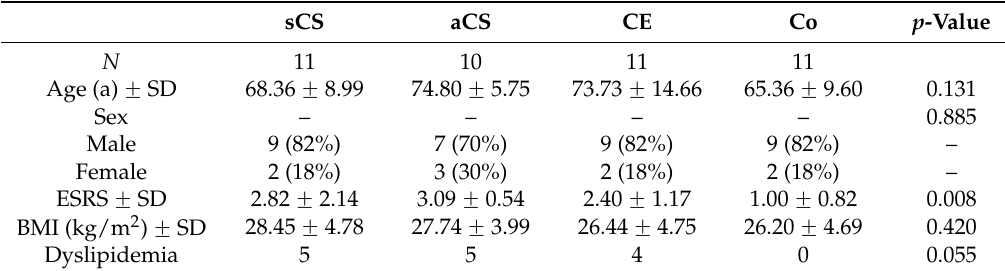
Table 1. Baseline